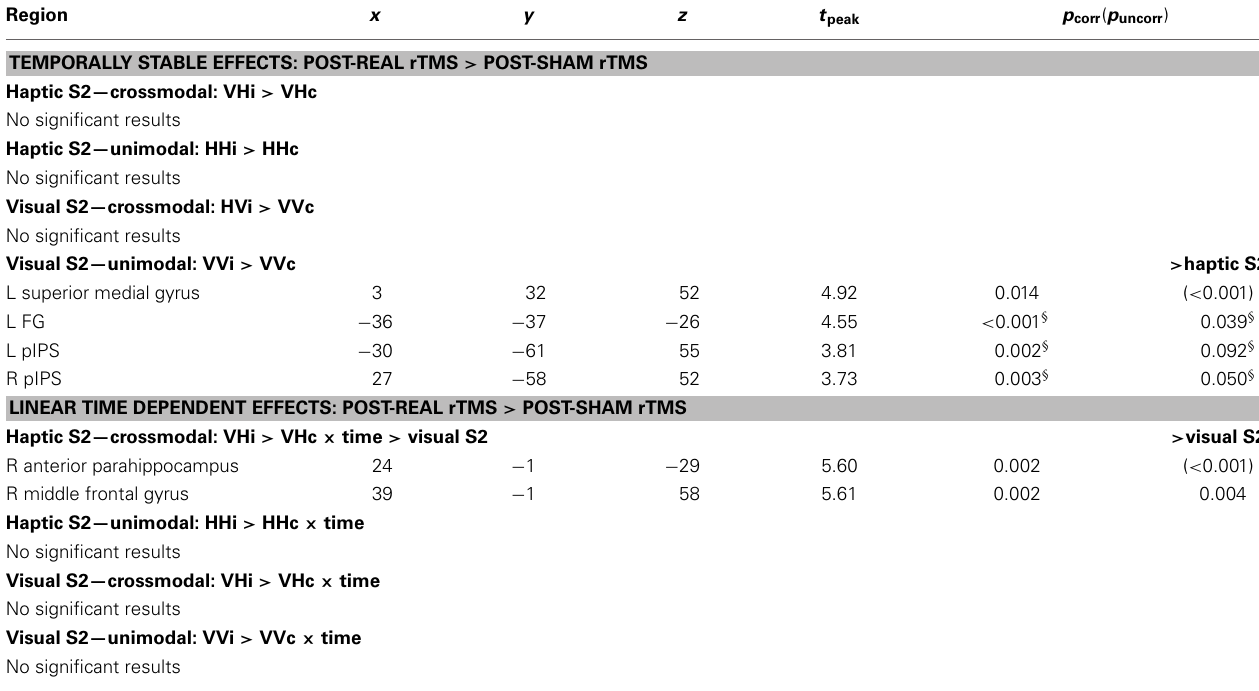
Table 3 | Real rTMS induced incongruency effects (incongruent > congruent × real rTMS > sham